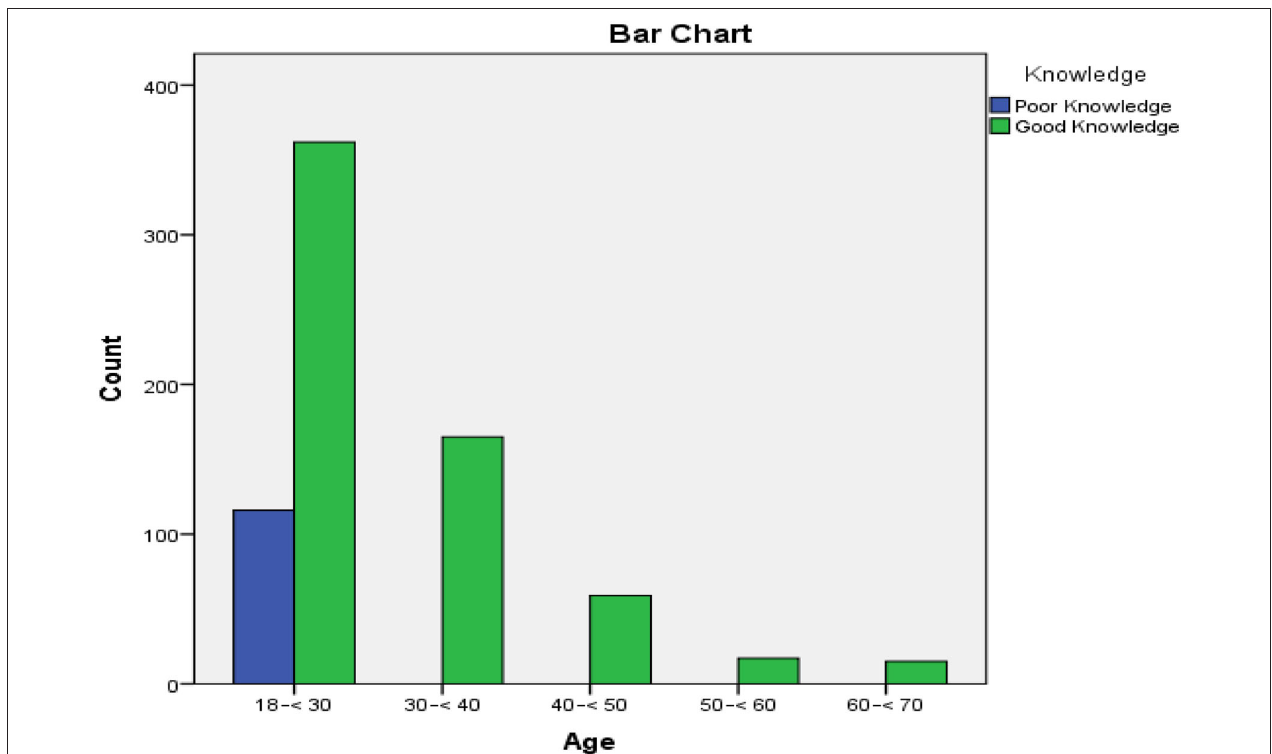
FIGURE 1 | Age-based knowledge response of the study participants toward COVID-19.